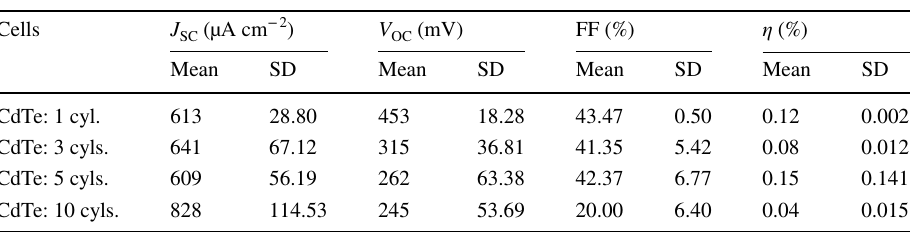
values of photovoltaic parameters obtained from four measurements